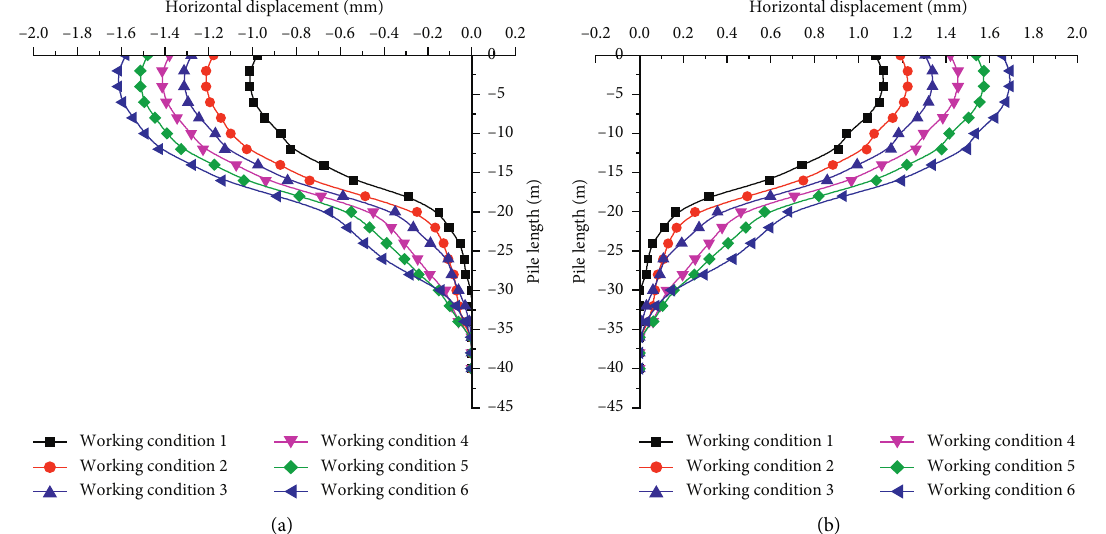
Figure 21: Horizontal displacement curve of pile foundation under different working conditions. (a) Measuring point 27. (b) Measuring point 29.